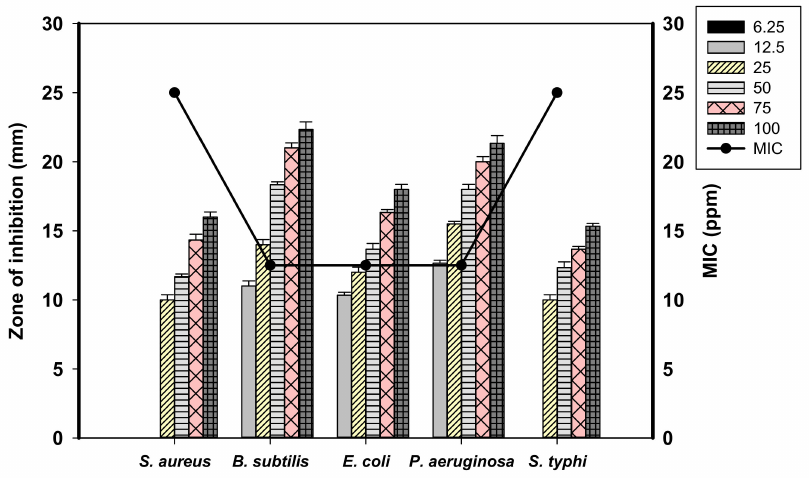
Figure 5. The antibacterial activity of Ag-NPs synthesized by S. laurentii R-1 against Staphylococcus aureus , Bacillus subtilis , Pseudomonas aeruginosa , Escherichia coli and Salmonella typhimurium .